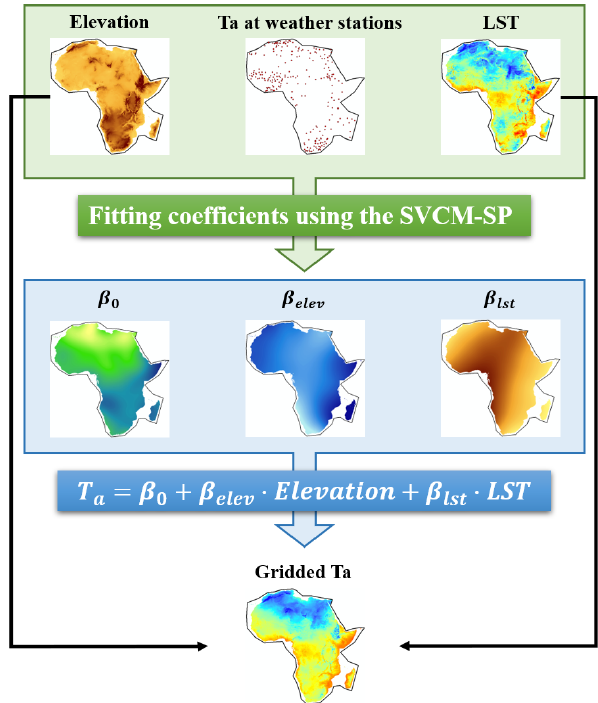
Figure 2. Framework for implementing the SVCM-SP algorithm in a region (e.g., Africa). β 0 , β elev , and β lst are the intercept, coeffi- cients of elevation, and LST,